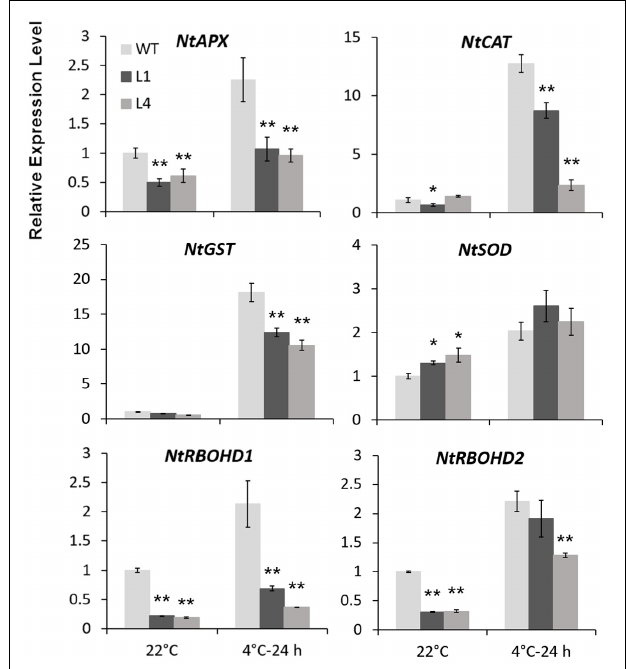
FIGURE 8 | CbRCI35 altered ROS homeostasis related genes expression. Relative expression levels of ROS scavenging genes including NtAPX , NtCAT , NtGST, and NtSOD , as well as ROS biosynthesis genes NtRBOHD1 and NtRBOHD2 in CbRCI35-ox tobacco plants with or without 4 ◦ C treatment. The NtActin gene was performed as an internal control. Expression levels were relative to that of WT plants. Data are means ± SD ( n = 3, ∗ P < 0.05, ∗∗ P <